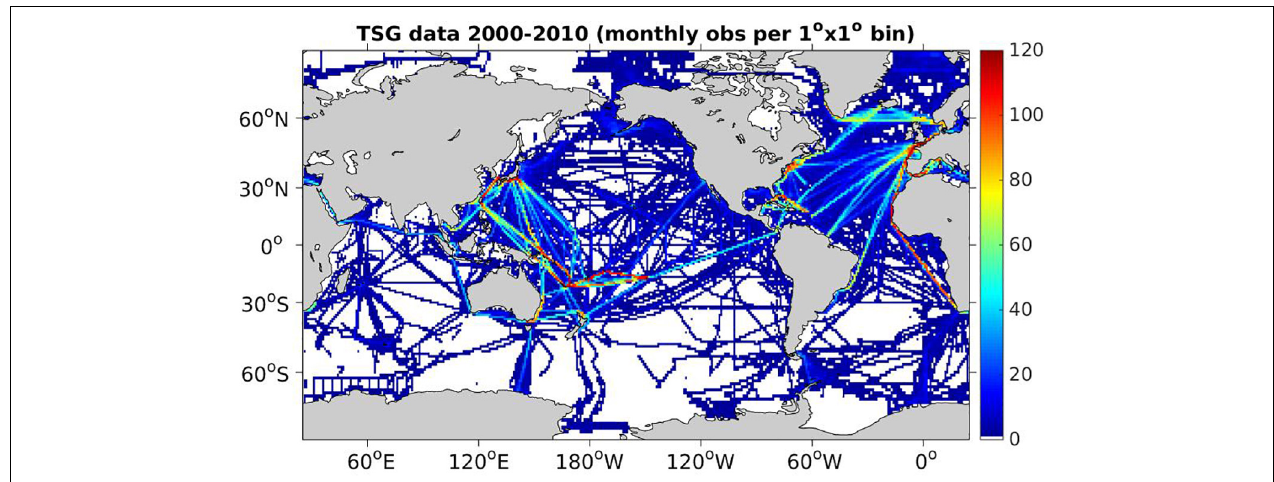
FIGURE 6 | Density map of global real-time and delayed-mode thermosalinograph observations covering 2000–2010 from multiple data sources, including the following: French Sea Surface Salinity Observation Service; GOSUD; SAMOS; National Oceanic and Atmospheric Administration Atlantic Oceanographic and Meteorological Laboratory, Pacific Marine Environmental Laboratory, and National Centers for Environmental Information; Japan Agency for Marine-Earth Science and Technology; Japan National Institute for Environmental Studies; VOS Nippon; Commonwealth Scientific and Industrial Research Organisation; Australian Antarctic Division; and the Alfred Wegener Institute for Polar and Marine